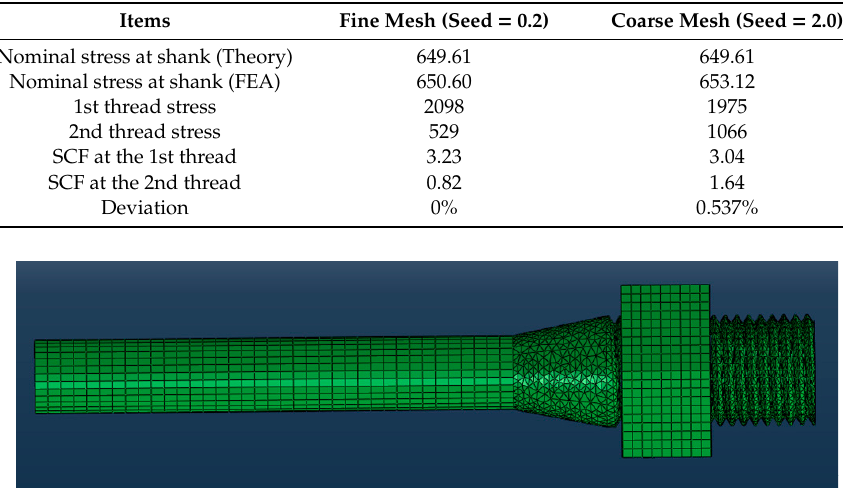
Figure 9. Nut type (standard nut and round nut).